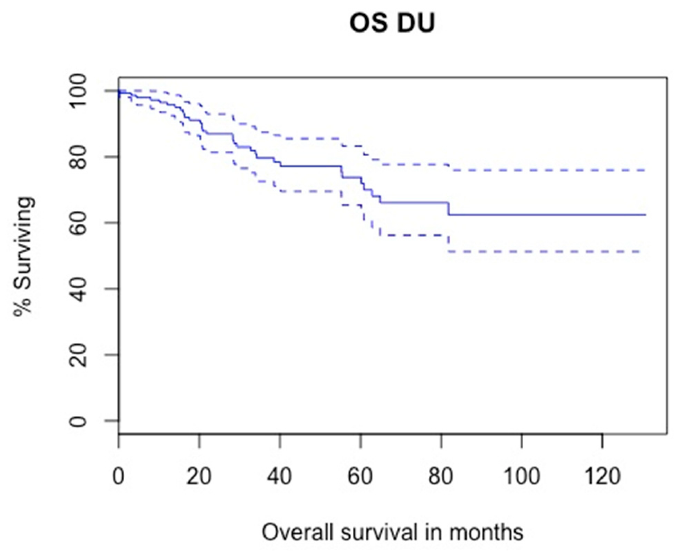
Figure 2. Kaplan–Meier modelling of overall survival (5-year OS: 71.9%, lower—upper 95%CI 0.632–0.819).